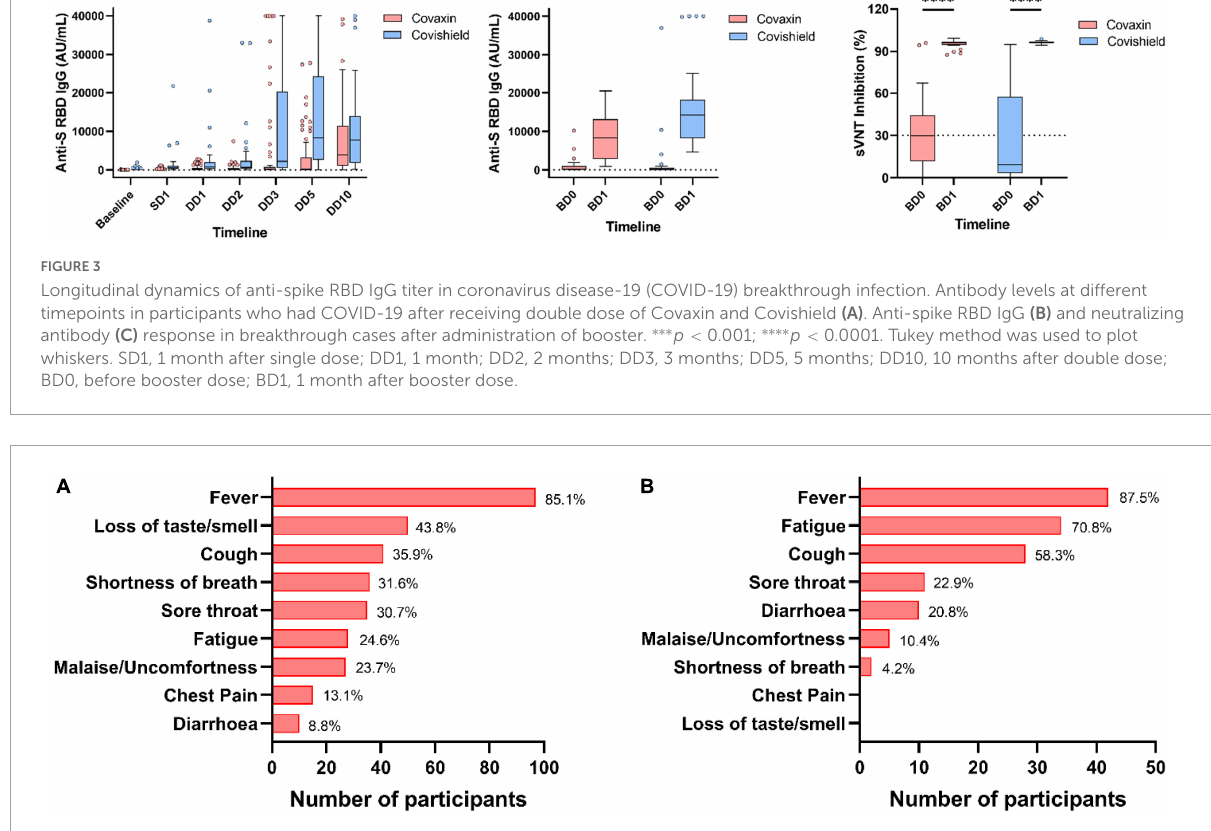
FIGURE4 Status of symptoms in coronavirus disease-19 (COVID-19) cases. The percentages of various symptoms reported by the breakthrough cases post double dose vaccination (A) and post booster dose (B) .